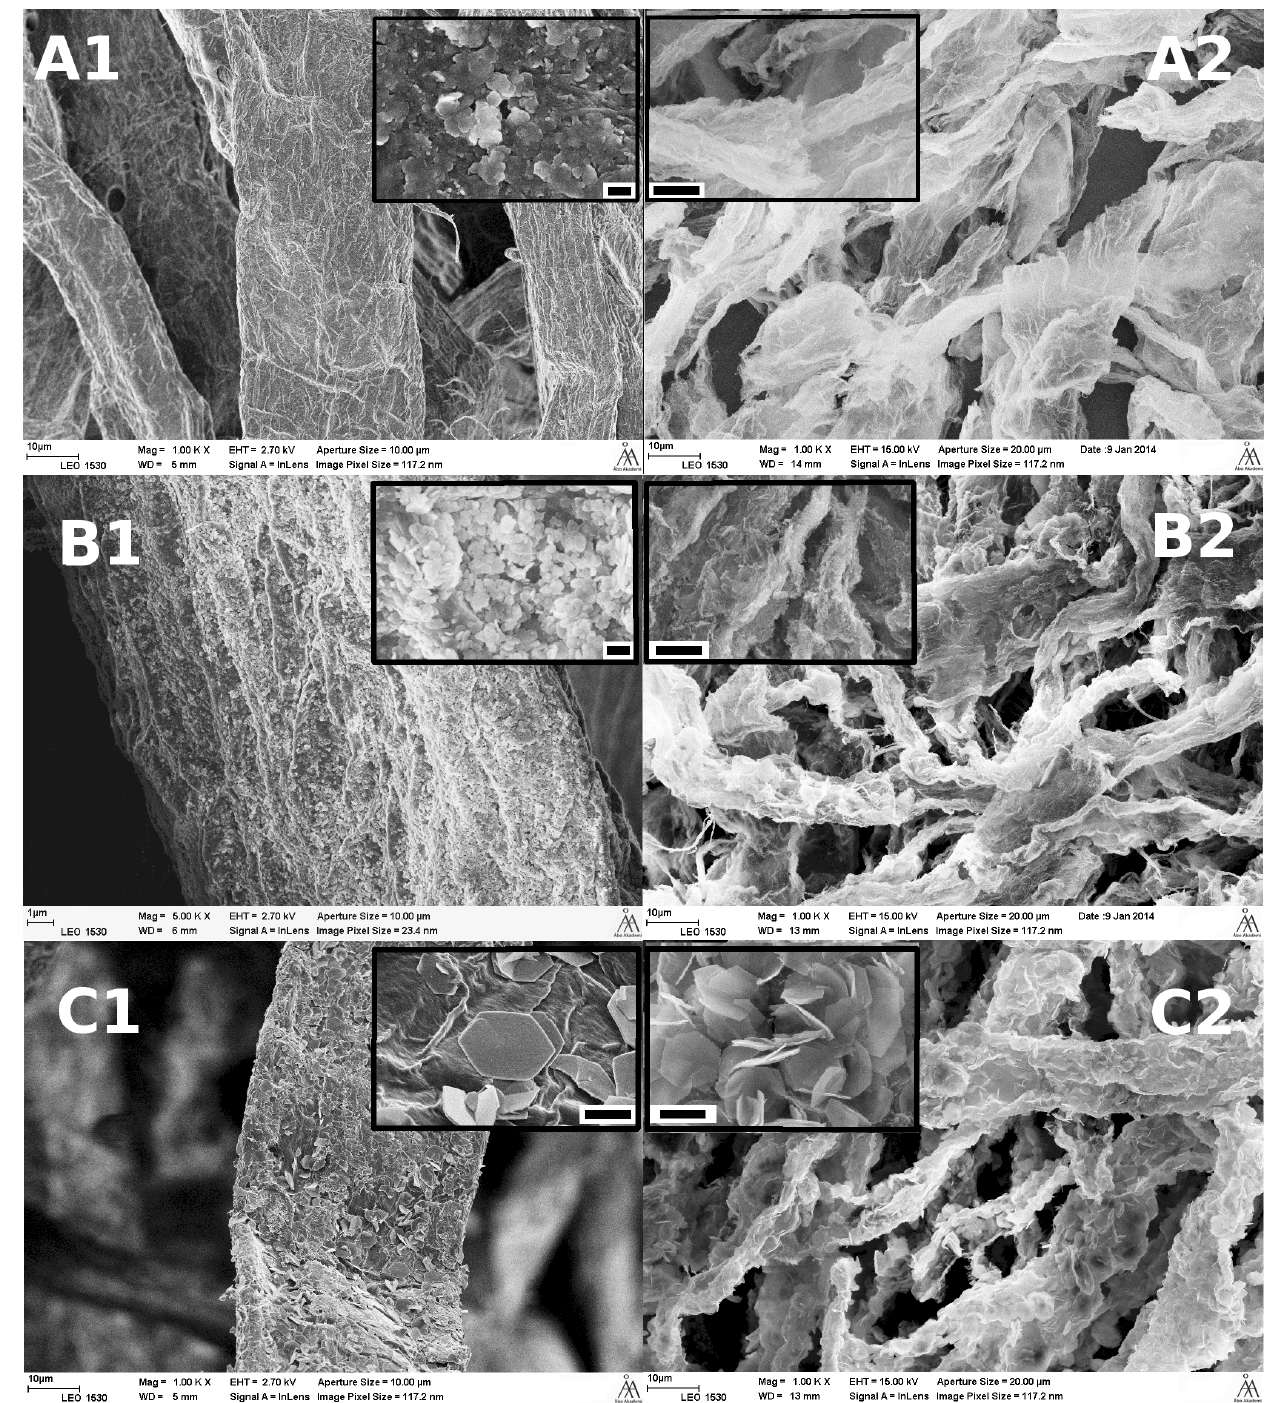
Figure 5. SEM images of ( A ) lss synthesised; ( B ) hss synthesised and ( C ) Uhyd synthesised fibers before (1) and after (2) TG analysis. The scale bar in the insets are ( A 1 and B 1) 200 nm and ( C 1– C 2) 2.0 µ m. The width of a collapsed wood fiber before incineration was approximately 30–40 µ